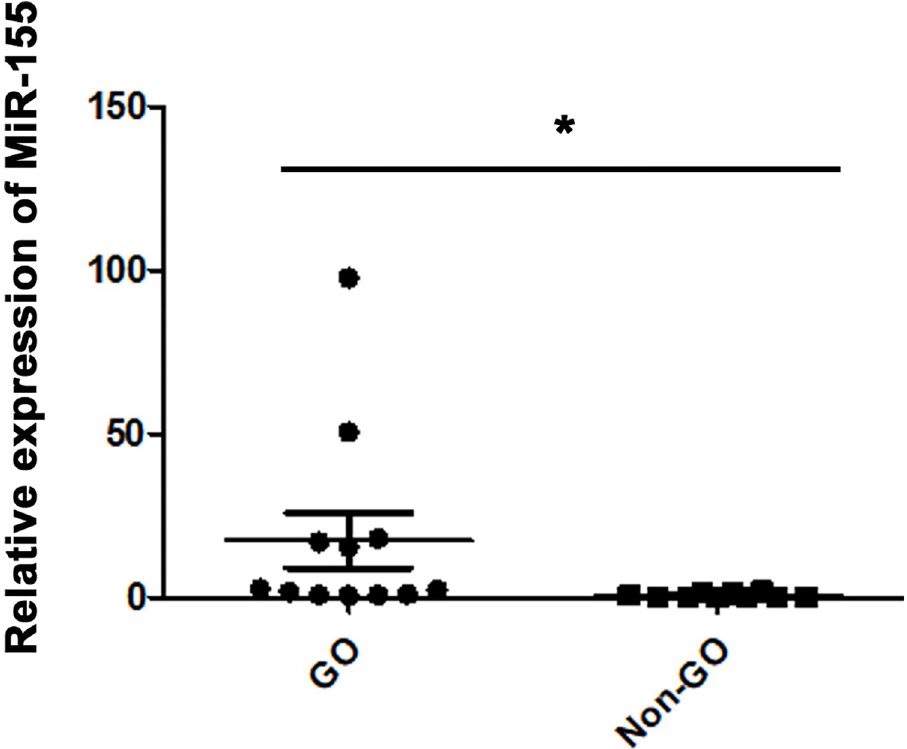
Fig 1. Expression of microRNA (miR)-155 in the orbital tissue of patients with Graves’ orbitopathy (GO, n = 12) and non-GO patients (n = 10). ( � P < 0.05, comparison between GO and non-GO in orbital adipose tissues).